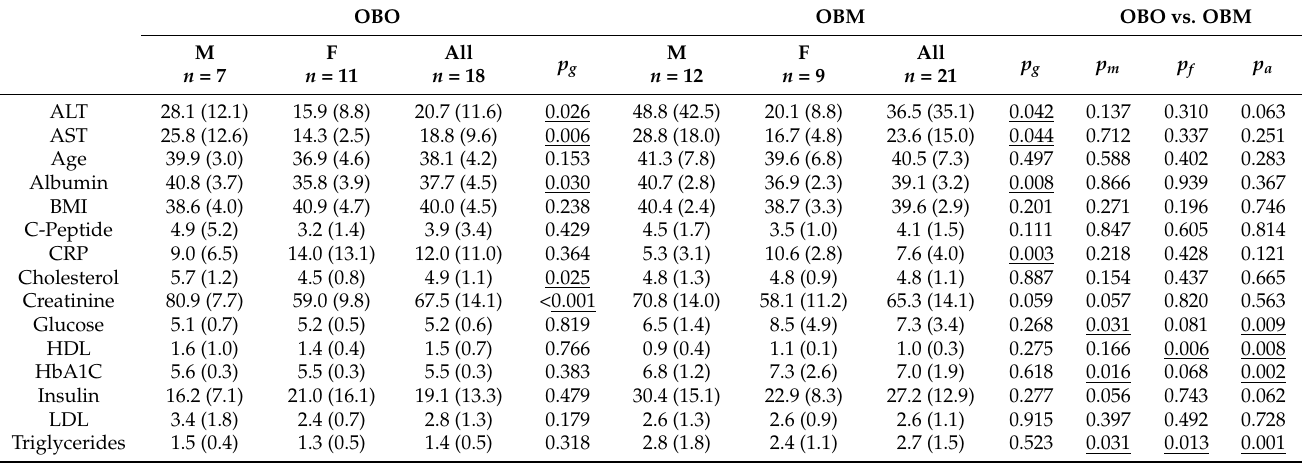
Table 1. Cohort characteristics with reported mean (standard deviation) for all variables: p -values cor- respond to differences between the means; underlined p -values are significantly below the threshold of